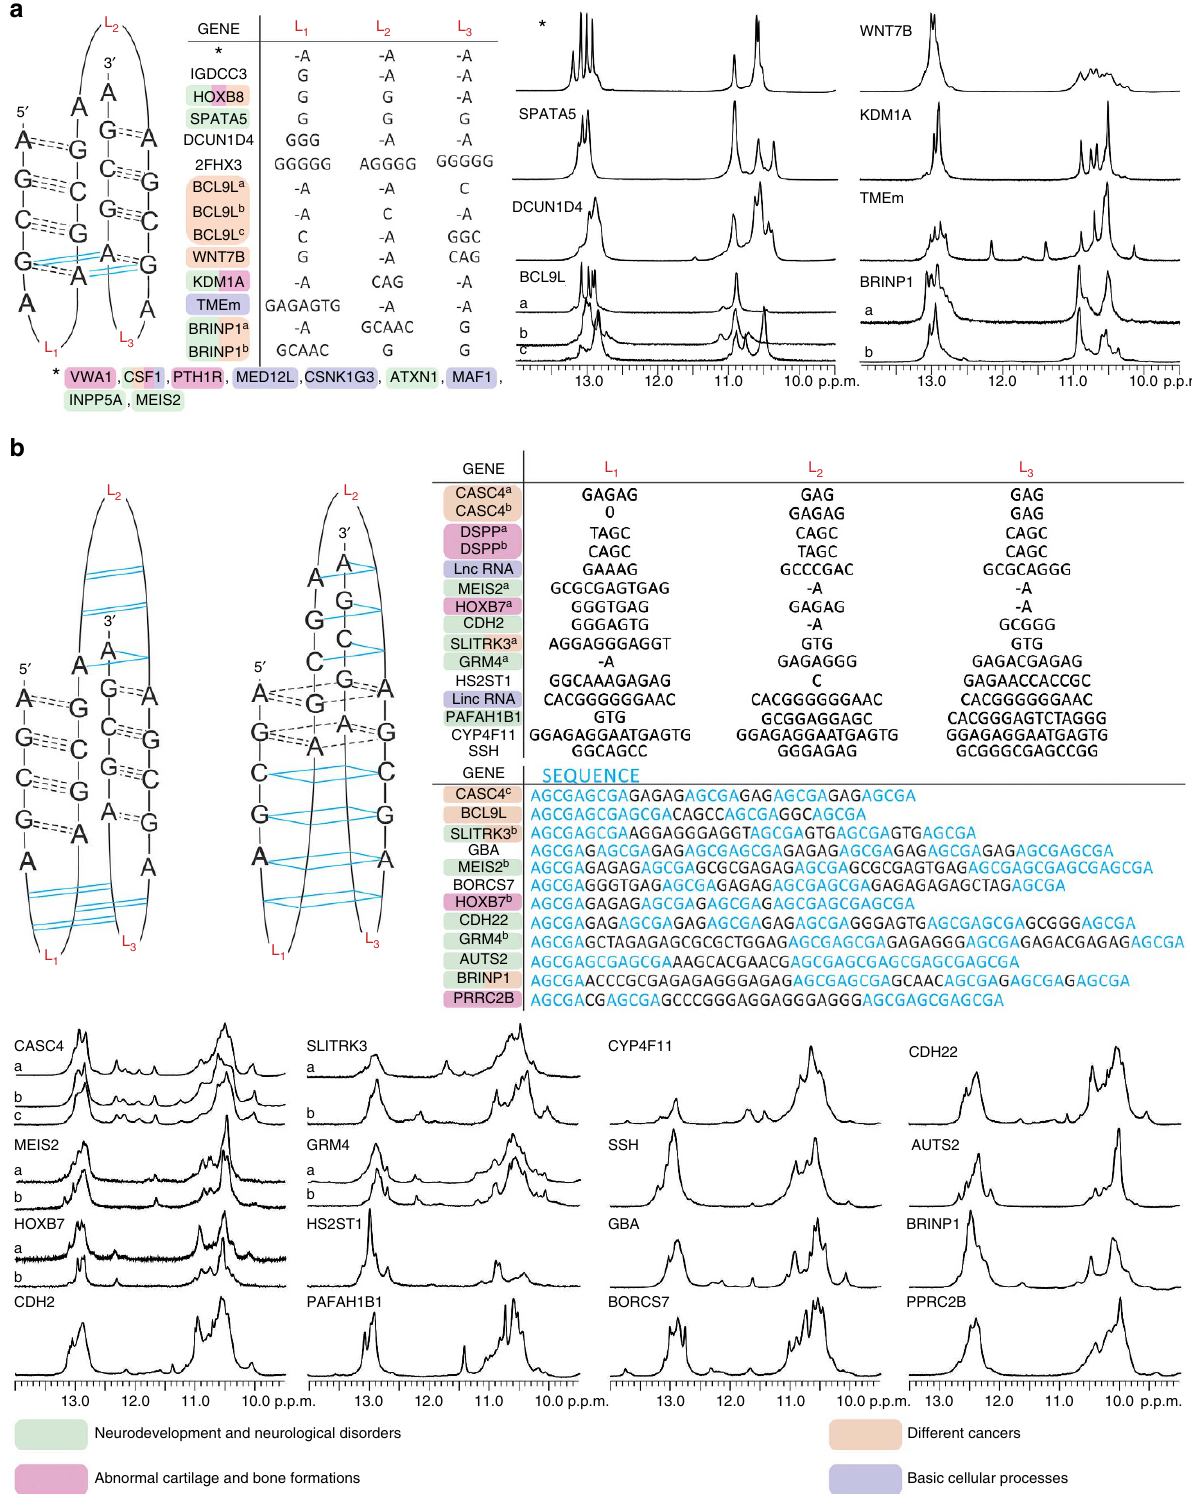
Basic cellular processesAbnormal cartilage and bone